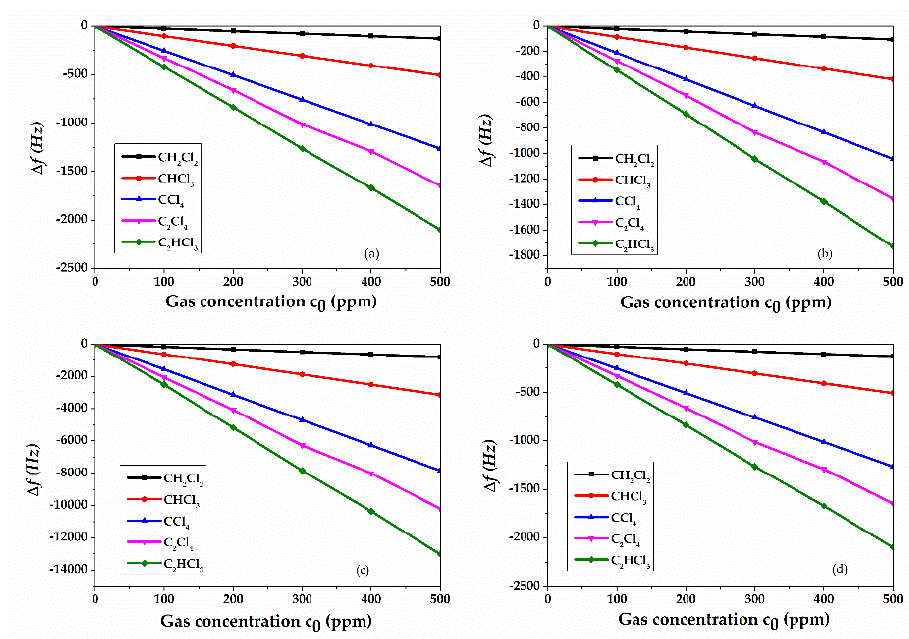
Figure 11. The frequency shift vs. gas concentration curves of the ( a ) Rayleigh and ( b ) Sezawa; the third harmonic of ( c ) R m and ( d ) S m .